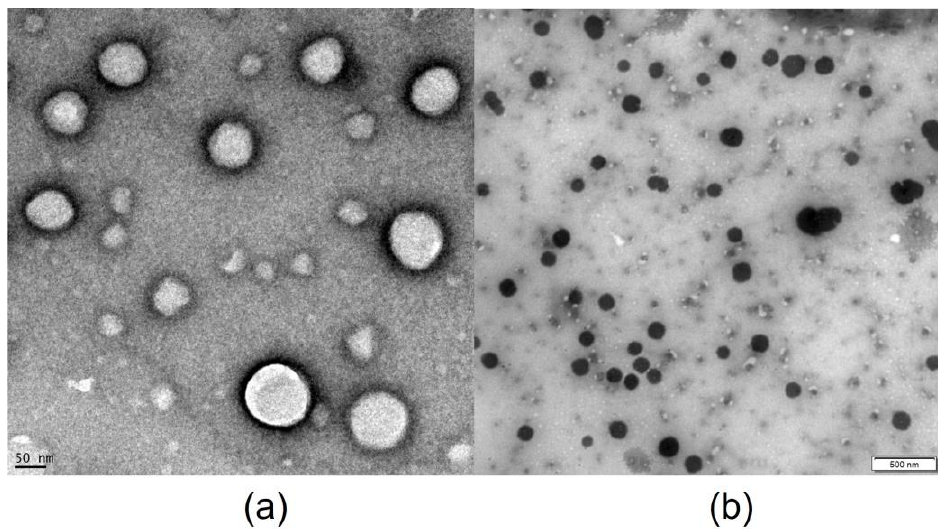
Figure 2. Transmission Electron Microscopy (TEM) images of saturated solution of ( a ) natamycin in 40% ( w/v ) HPβCD solution and 1% ( w/v ) voriconazole solution and ( b ) saturated solution of natamycin in 40% ( w/v ) HPβCD solution.